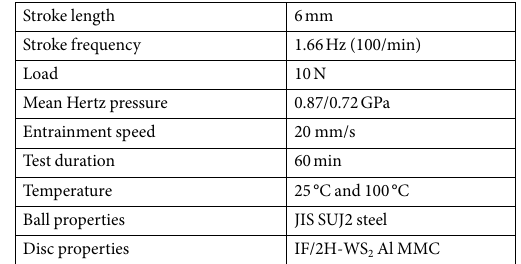
Table 1. Reciprocating test